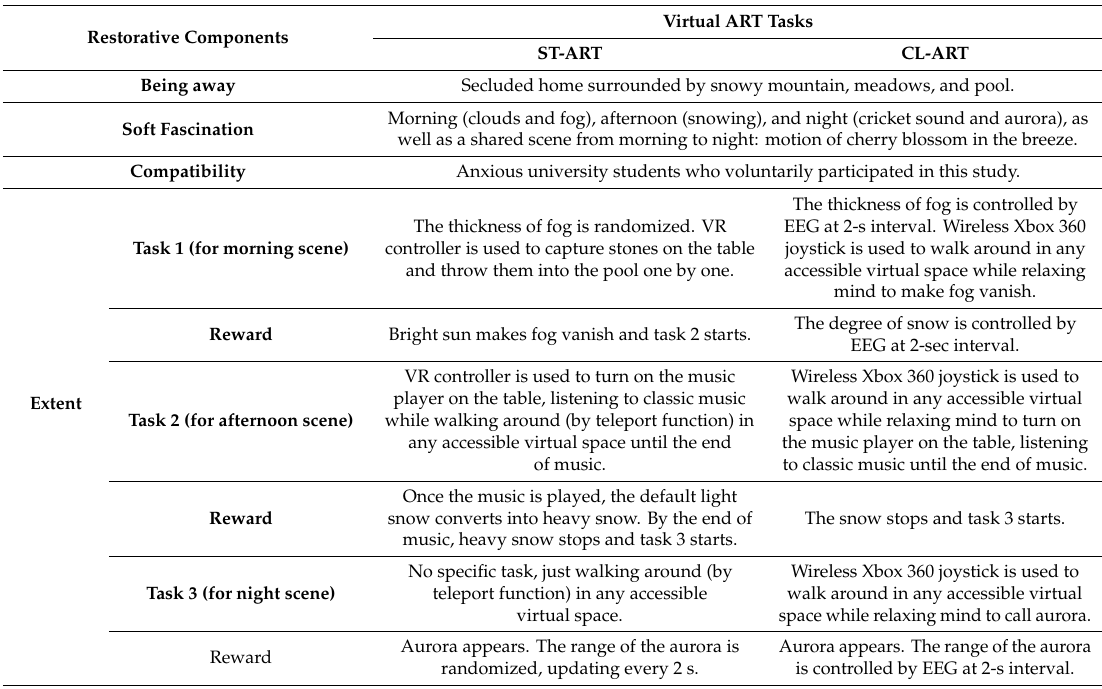
Table 1. Comparison of standard attention restoration theory (ST-ART) and closed-loop attention restoration theory (CL-ART)